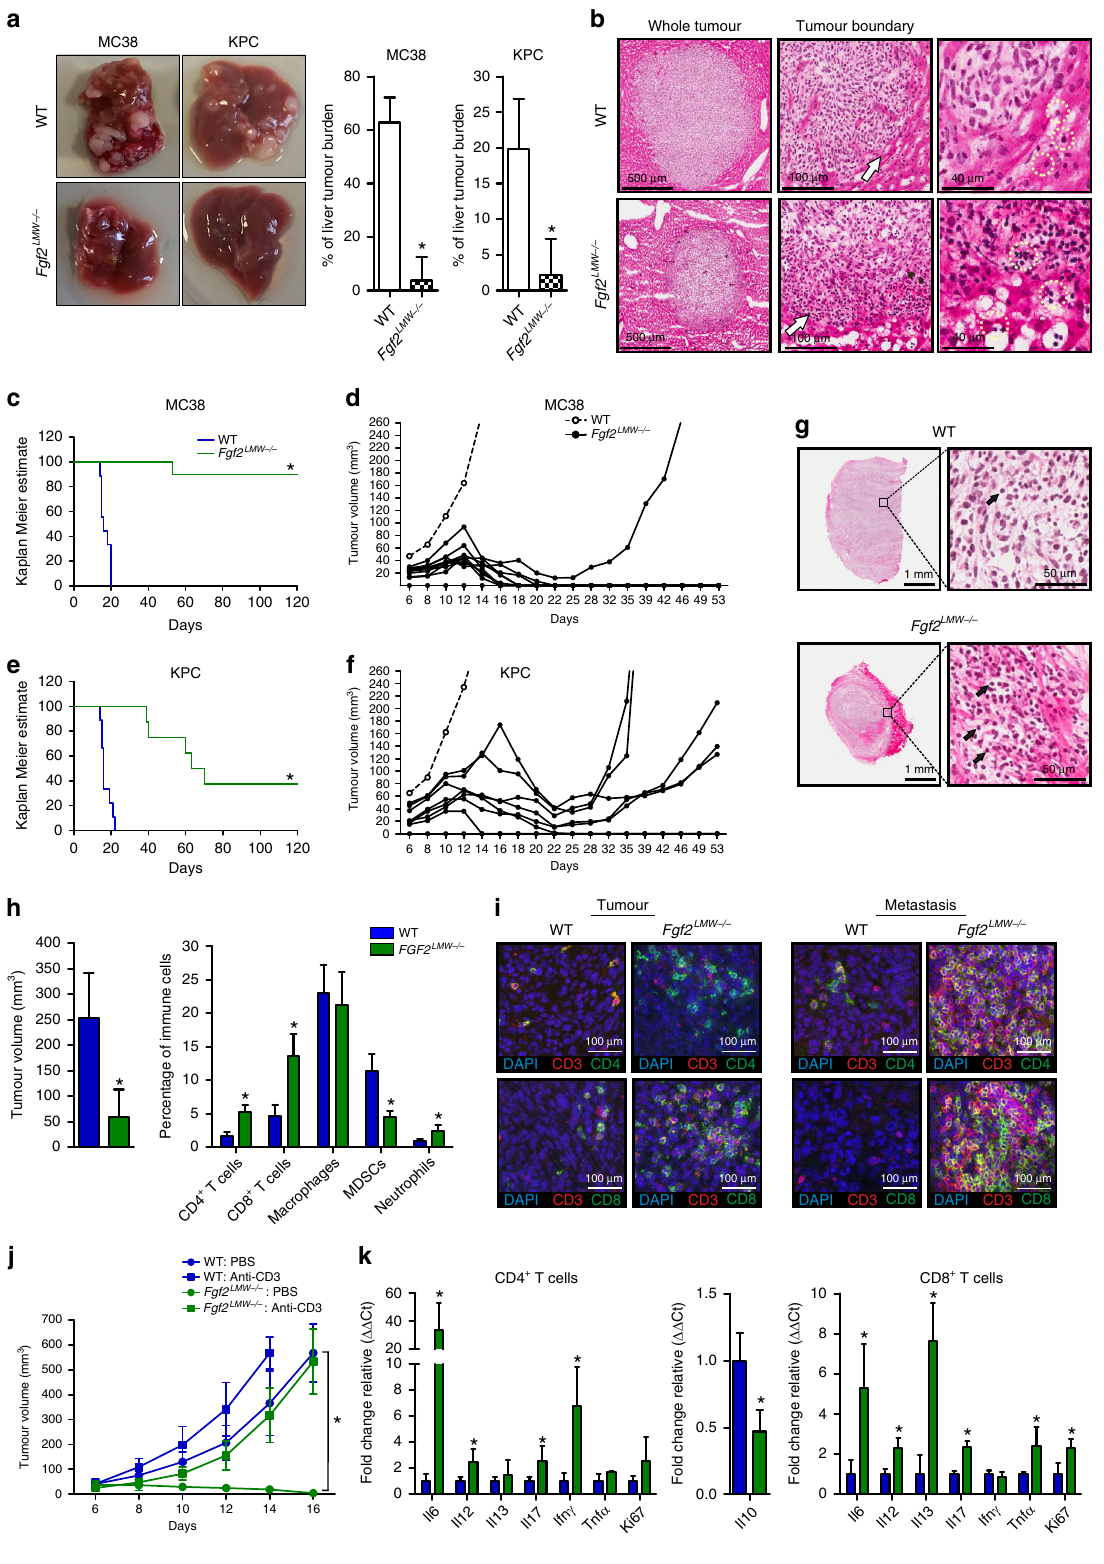
Macrophages express FGF receptors following interaction with tumour cells . Since an immune response was required for tumour regression in Fgf2 LMW − / − mice, we asked which immune cells expressed FGF2 receptors. Despite the involvement of T cells in tumour regression, we failed to detect FGFR1 or 2 on T cells or other immune cell types from either naïve mice or from tumour